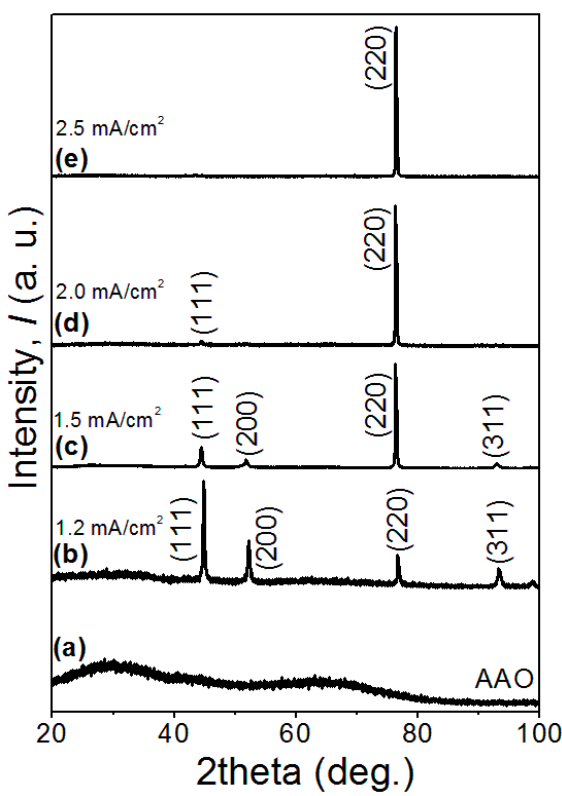
Figure 1. Typical XRD spectra of (a) AAO template, (b–e) Ni nanowire arrays prepared at various current densities (1.2 mA/cm 2 ~2.5 mA/cm 2 ). The Ni nanowire arrays that obtained at a low current density (1.2 mA/cm 2 ) has a polycrystalline structure, while the nanowire arrays grow along the [110] orientation at a higher current density (2.5 mA/cm 2 ).